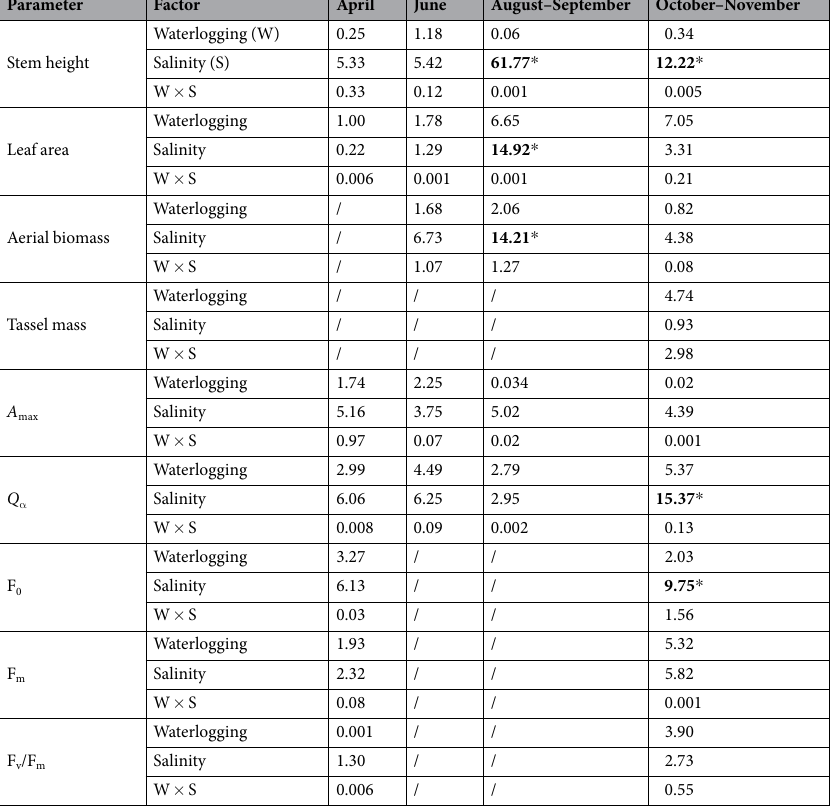
Table 2. Main and interactive effects ( F -values) of waterlogging and salinity on the growth and photosynthetic parameters in S. alterniflora over the growing period. See the Supplementary Table for complete statistical information. * Significance at P < 0.05.